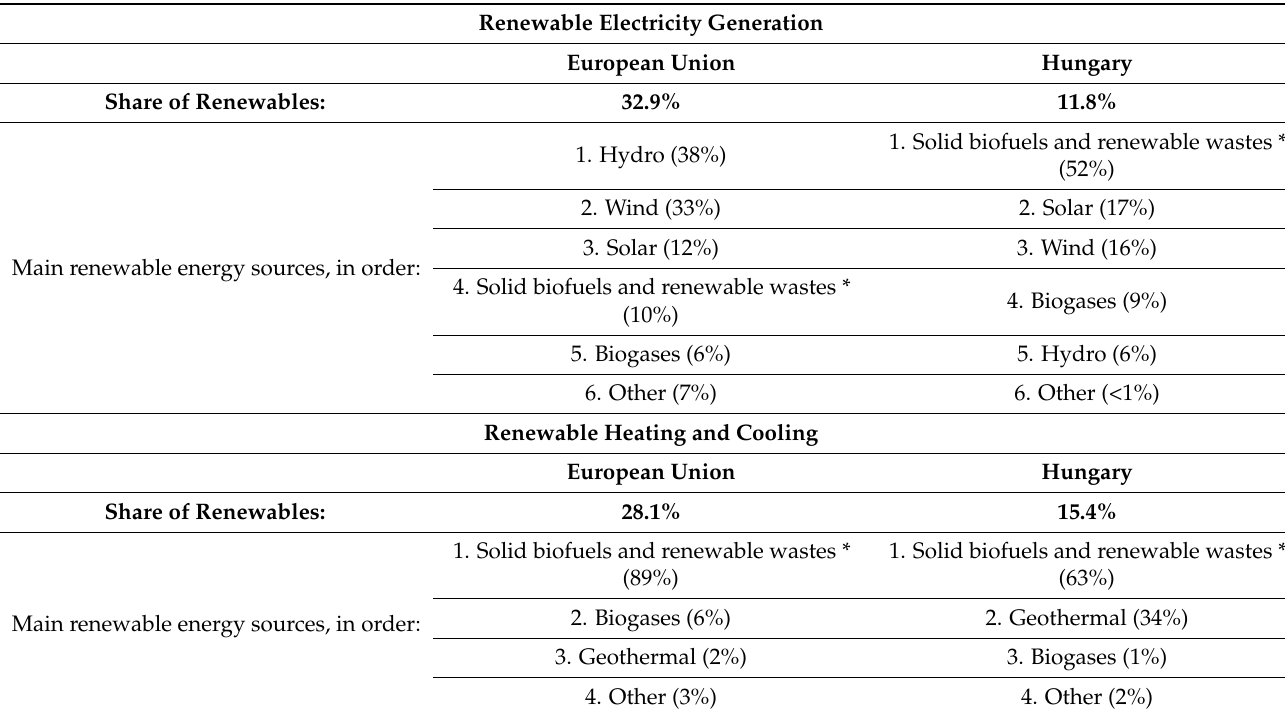
Table 1. Share and main sources of renewable electricity and heat generation in 2018 (European Union (EU) and Hungary). Renewable Electricity Generation European